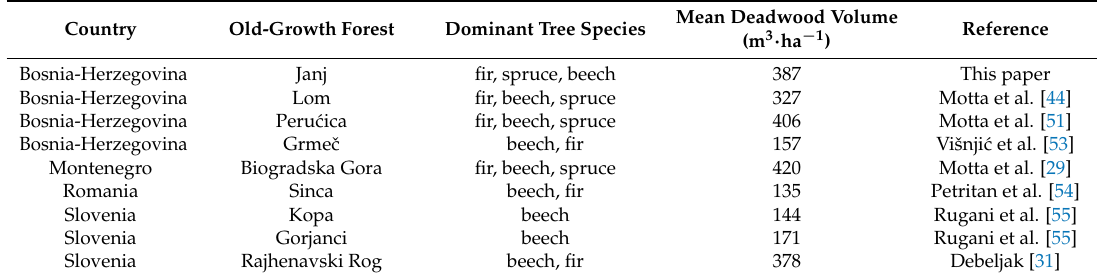
Table 5. The mean volume of deadwood in several old-growth forests of South-East Europe.